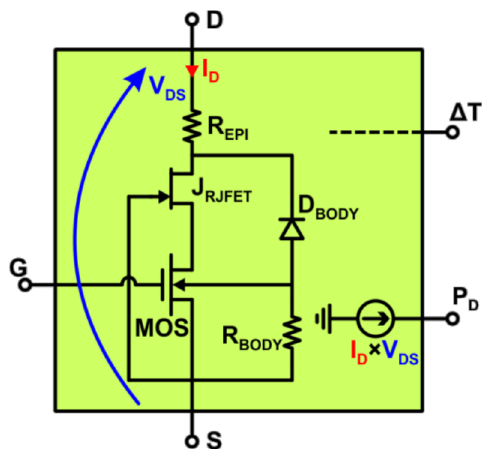
Figure 3. SPICE-compatible schematic implementing the behavioral model of the 3.3 kV SiC VDMOS transistor under analysis. The model includes three active components (the MOSFET, simply denoted as MOS, J RJFET , and D BODY ) and two nonlinear resistors (R EPI and R BODY